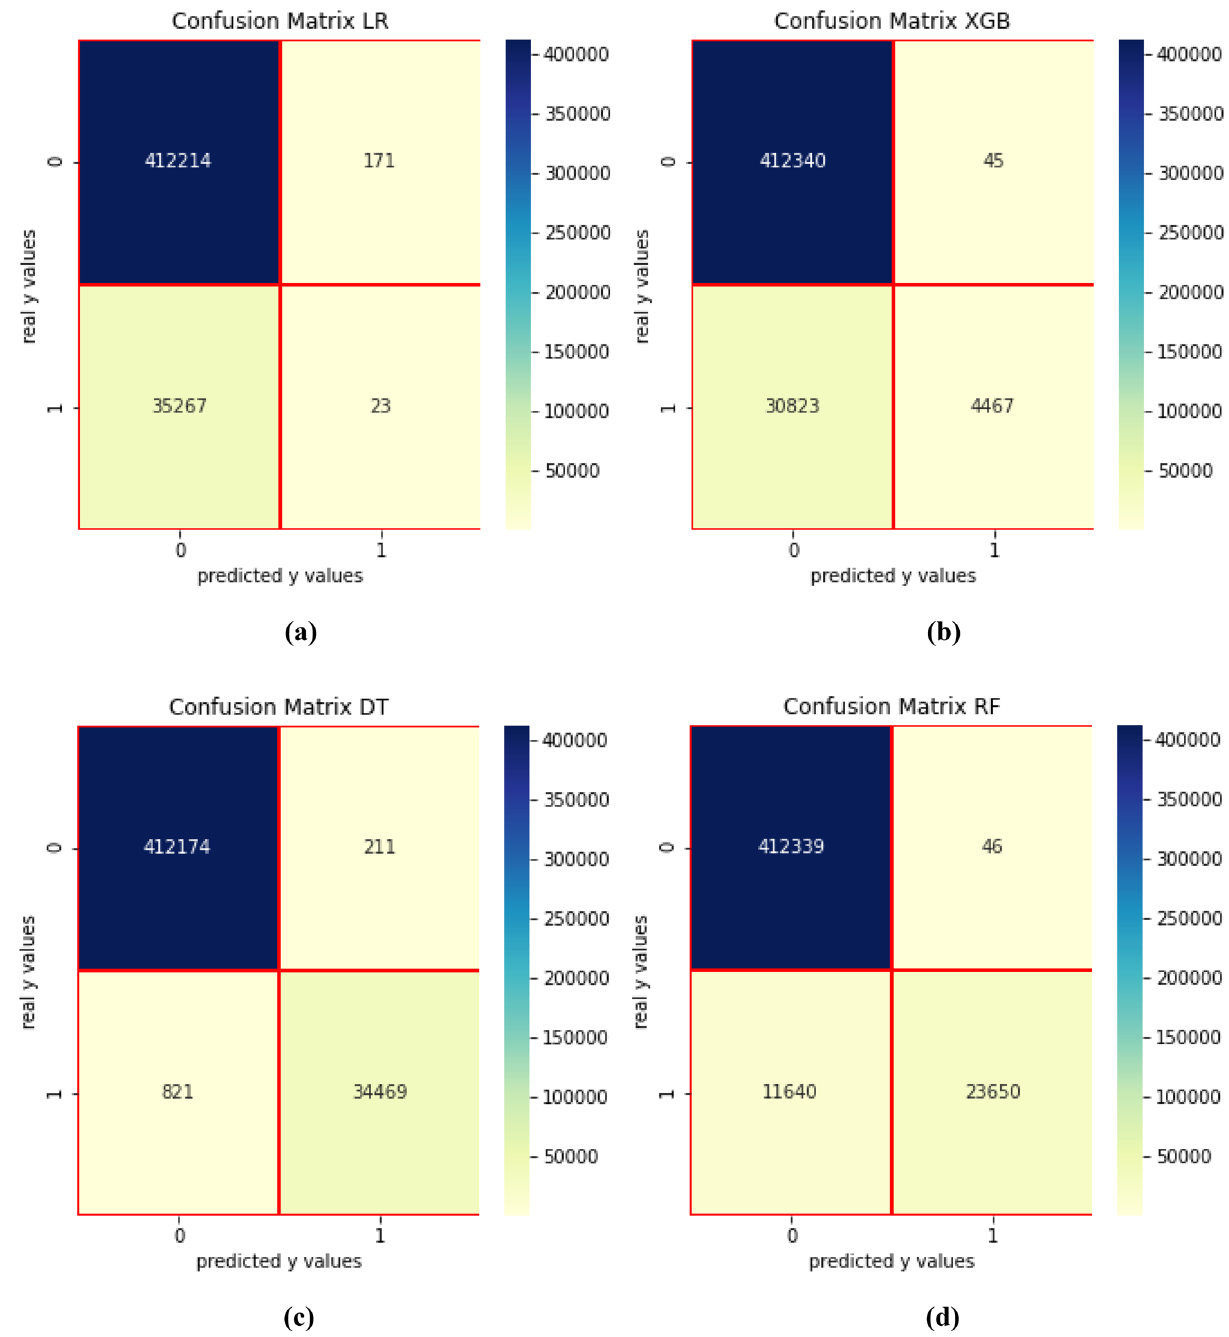
Figure 6. Confusion matrix—scenario 2. ( a ) LR, ( b ) XGB, ( c ) DT, ( d )